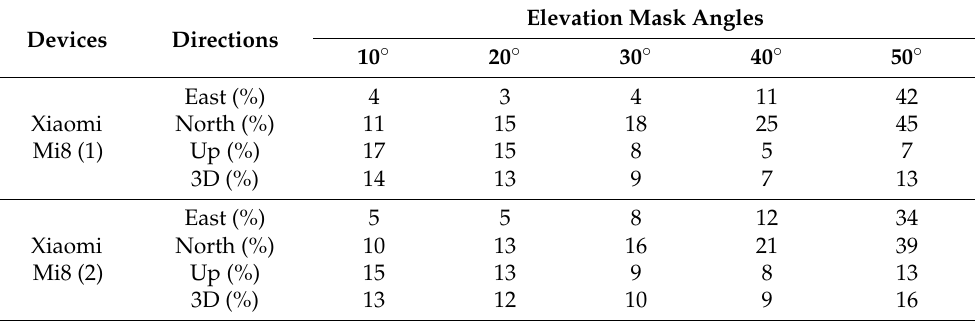
Table 9. Improvement rates of positioning accuracy in (m) for the smartphone-based four-system integrated SPP considering a priori ISB constraints over the one ignoring a priori ISB constraints under different elevation